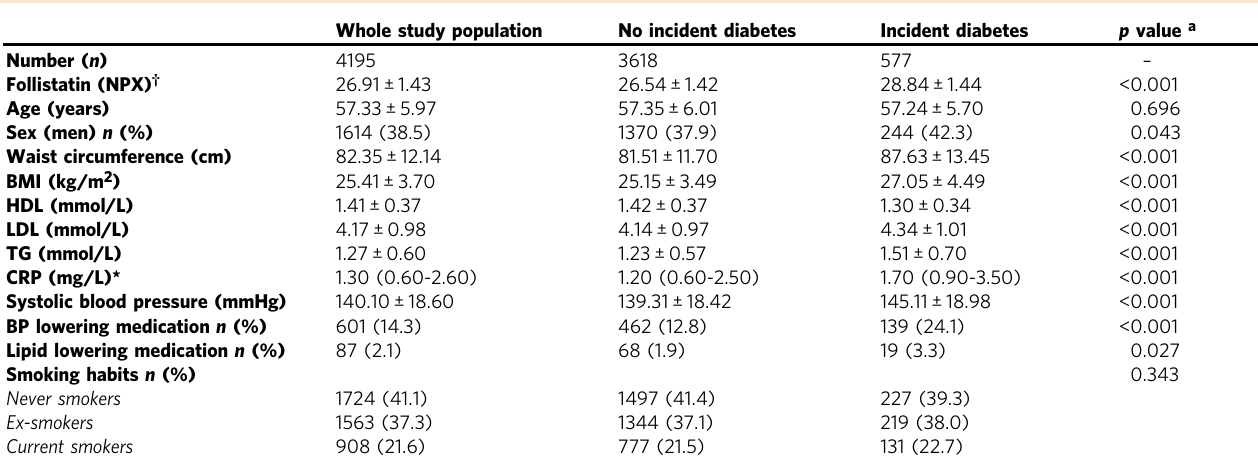
Table 1 Baseline characteristics of MDC-CC study population ( n =